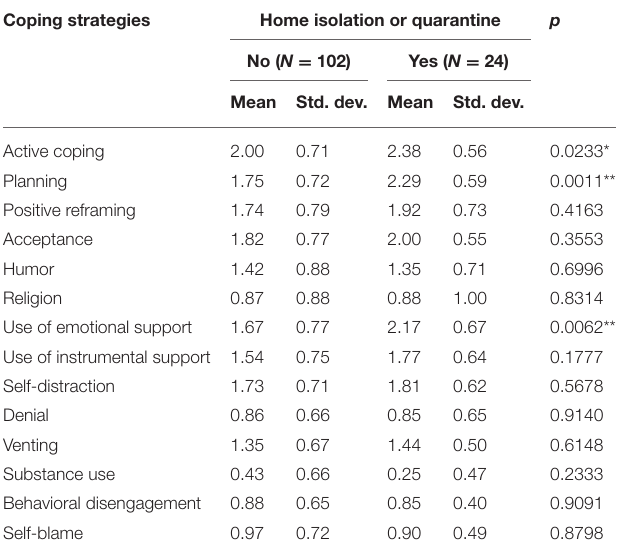
TABLE 4 | MiniCOPE strategies among nurses in Belarus who have undergone home isolation or quarantine. Coping strategies